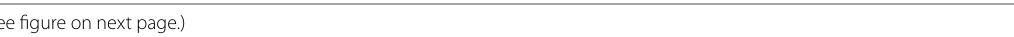
Fig. 7 Inflammatory mediator‑induced changes in the properties of TTX‑R Na + channels in small‑sized dural afferent neurons. A. a , Typical traces of TTX‑R I Na recorded from IM‑treated (gray) and vehicle‑treated (black) small‑ (left) and medium‑sized (right) DiI‑positive neurons. TTX‑R I Na were elicited by voltage step pulses (100 ms duration; ‑10 mV depolarization at a V H of ‑80 mV). Notably, TTX‑R I NaP were larger in the IM‑treated group than those in the vehicle‑treated group in small‑sized DiI‑positive neurons but not in medium‑sized DiI‑positive neurons. b , Scatter plot of the density of TTX‑R I NaP obtained from IM‑treated DiI‑positive neurons (gray circles; n n 42) against membrane capacitance (Cm). The linear trend lines represent the best fits using a least‑squares fit (IM‑treated group: r = vehicle‑treated group: